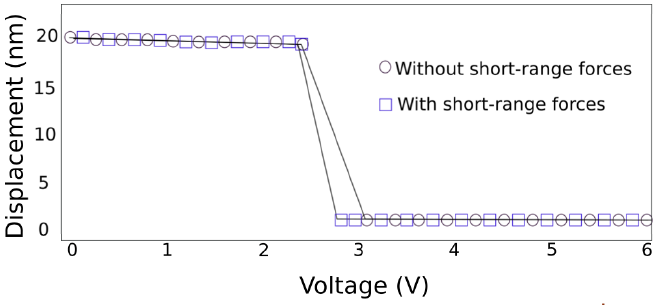
Figure 6. Set of pull-out trajectories featuring the electrostatic-based one (circle) in comparison with the trajectory that features the short-range forces and electrostatic